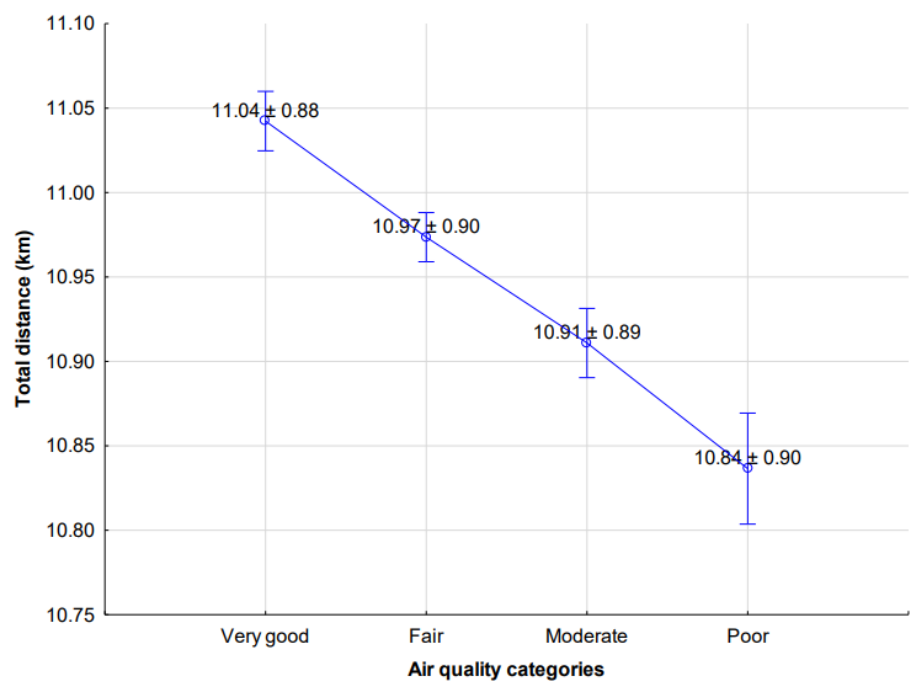
Figure 1. Differences in total distance covered by soccer players in relation to changes in air quality categories (mean ± SE). Differences statistically significant between very good vs. fair p = 0.01, fair vs. moderate p = 0.01, and moderate vs. poor p = 0.05 (Source: own elaboration).